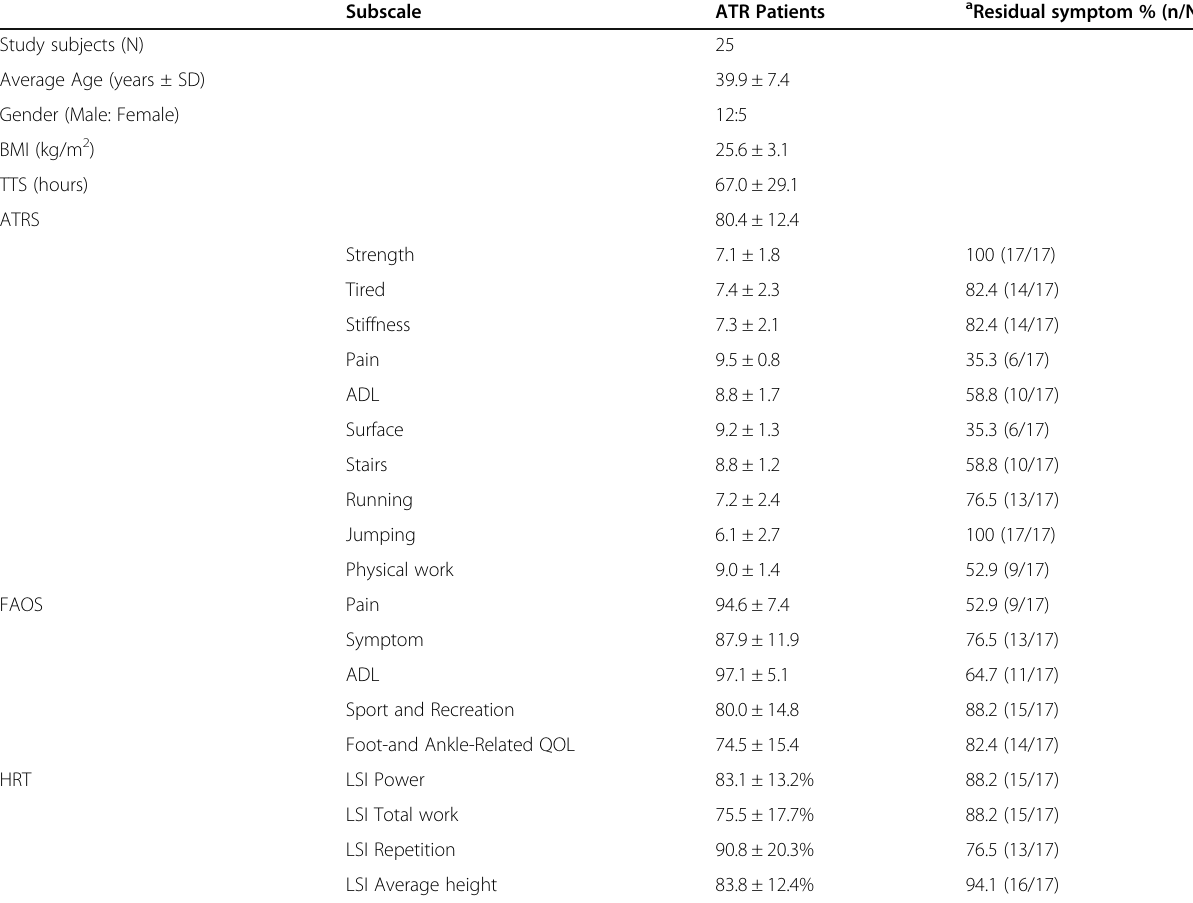
Table 2 Basic characteristics of subjects and their clinical information Subscale ATR